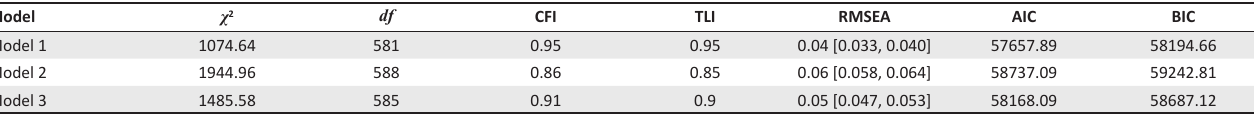
TABLE 2: Fit statistics of competing measurement models. Model